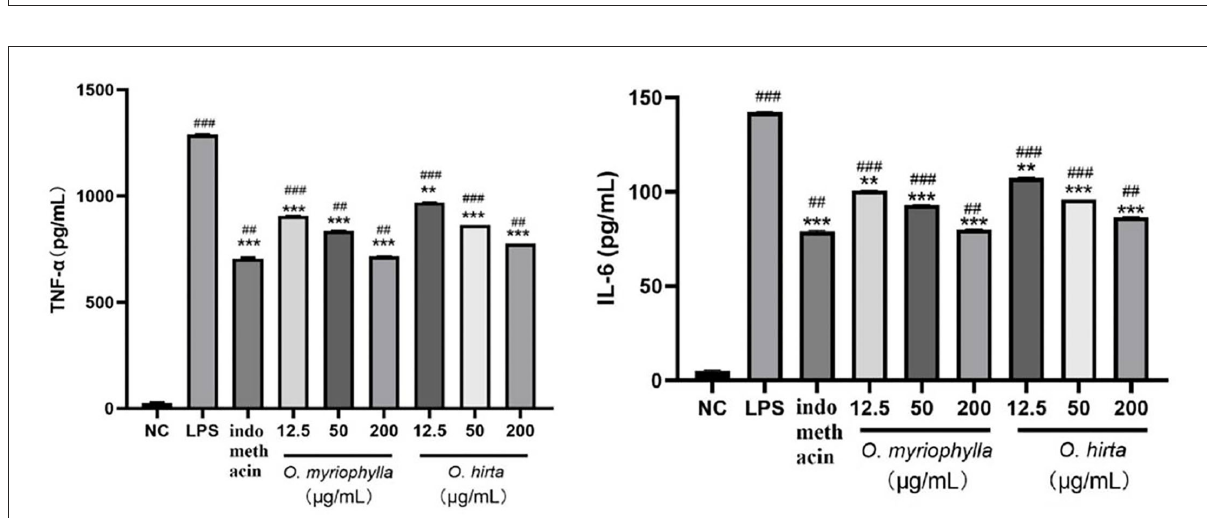
FIGURE10 Effects of O. myriophylla and O. hirta on LPS-induced TNF- α and IL-6 expression in mouse RAW 264.7 macrophages (NC, blank control group; LPS, 1 µ g/mL LPS group; indomethacin: 100 µ M indomethacin + 1 µ g/mL LPS group. Compared with the NC group, ## P < 0.01, ### P < 0.001; compared with the model group (LPS group), ** P < 0.01, *** P <